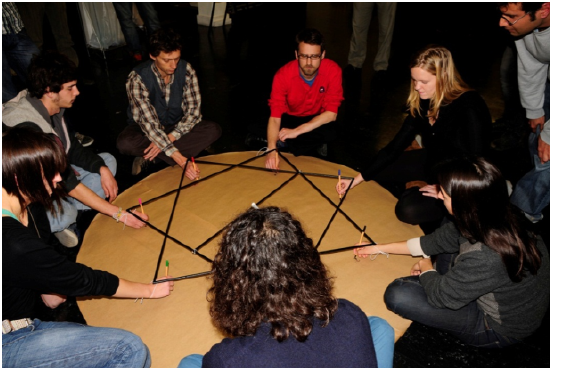
Fig. 7 . Breathing Feedbacks: a successful trial run. Without conscious effort, participants’ breaths synchronize in response to hearing the collective breathing over the speakers.